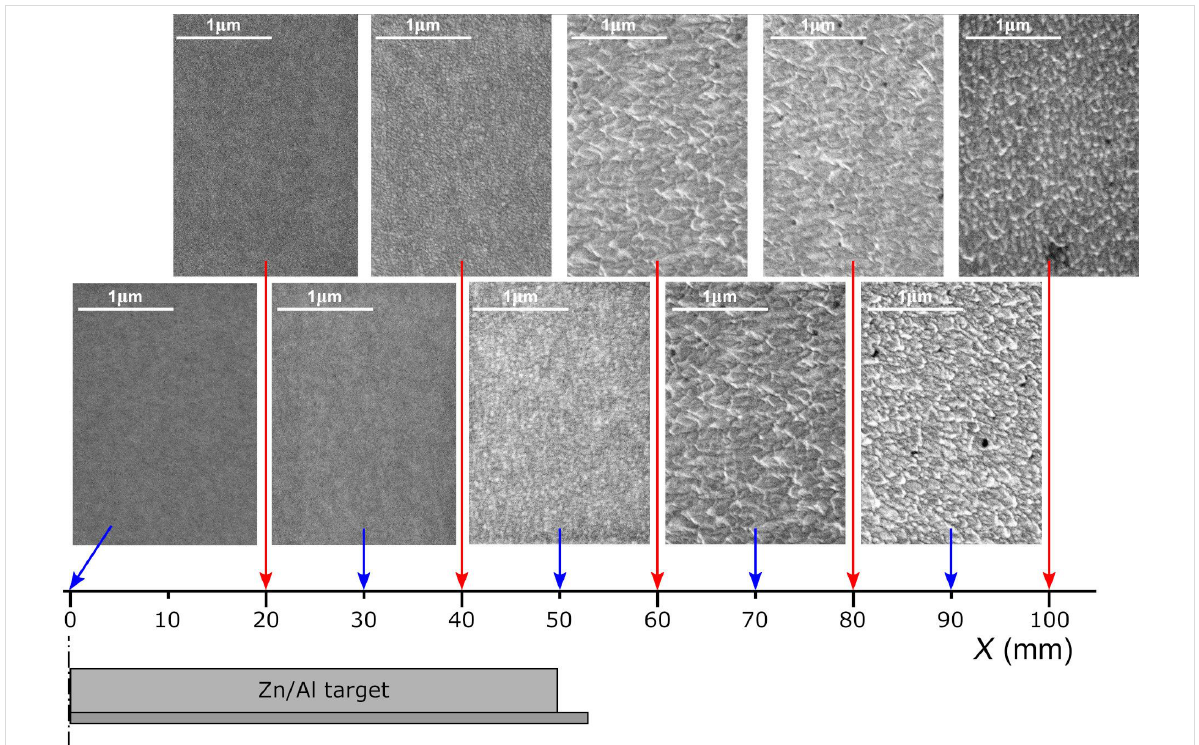
Figure 10: SEM images of the surface of thin films deposited on the front substrate surface at different distances X from the target axis.